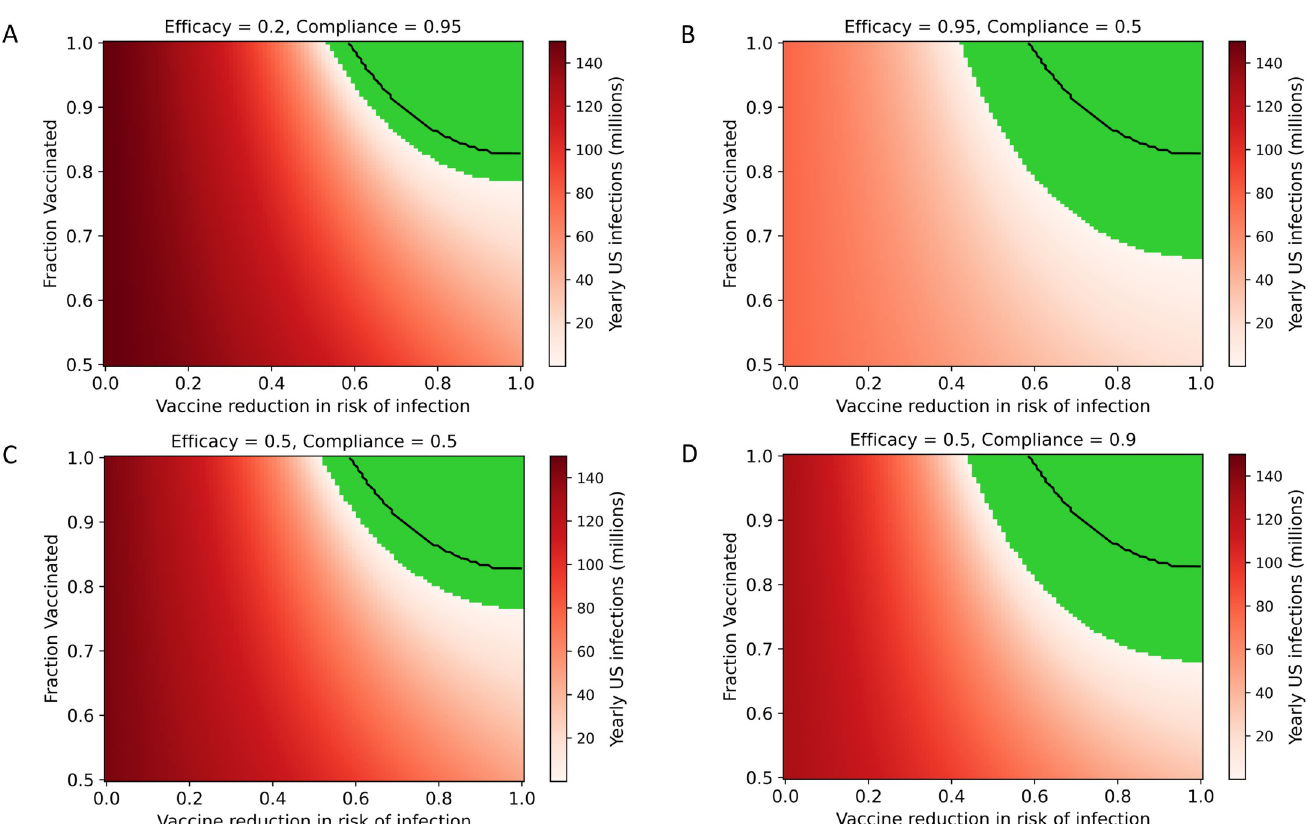
Fig 5. Interventions complementary to the vaccine improve suppression potential of a vaccine (Assumptions are: R 0 = 5.7, 18-month immunity). Black lines outline the suppression space for the vaccine alone. In the figure panels, four example complementary interventions are explored: A) a passive intervention, such as improving ventilation in schools and workplaces, which impacts 95% of the population but has a small 20% impact on risk of infection; B) a highly effective (95%) intranasal prophylactic that 50% of the population uses; C) a mutually compatible, competing vaccine achieving 50% reduction in risk of infection and 50% compliance in the population; and D) universal masking, which reduces the risk of infection by 50% and reaches 90%